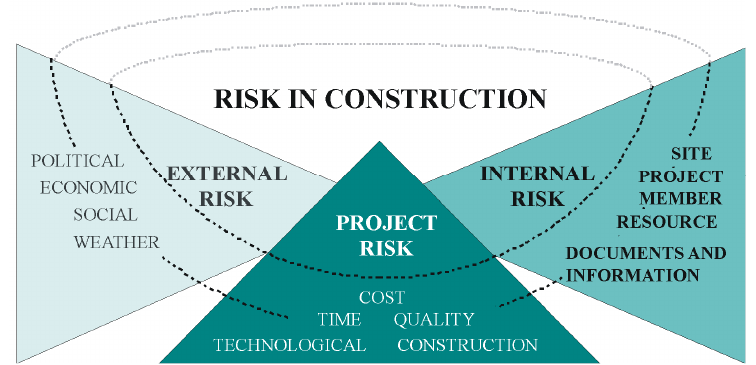
Fig. 2. Risk allocation structure by level in construction